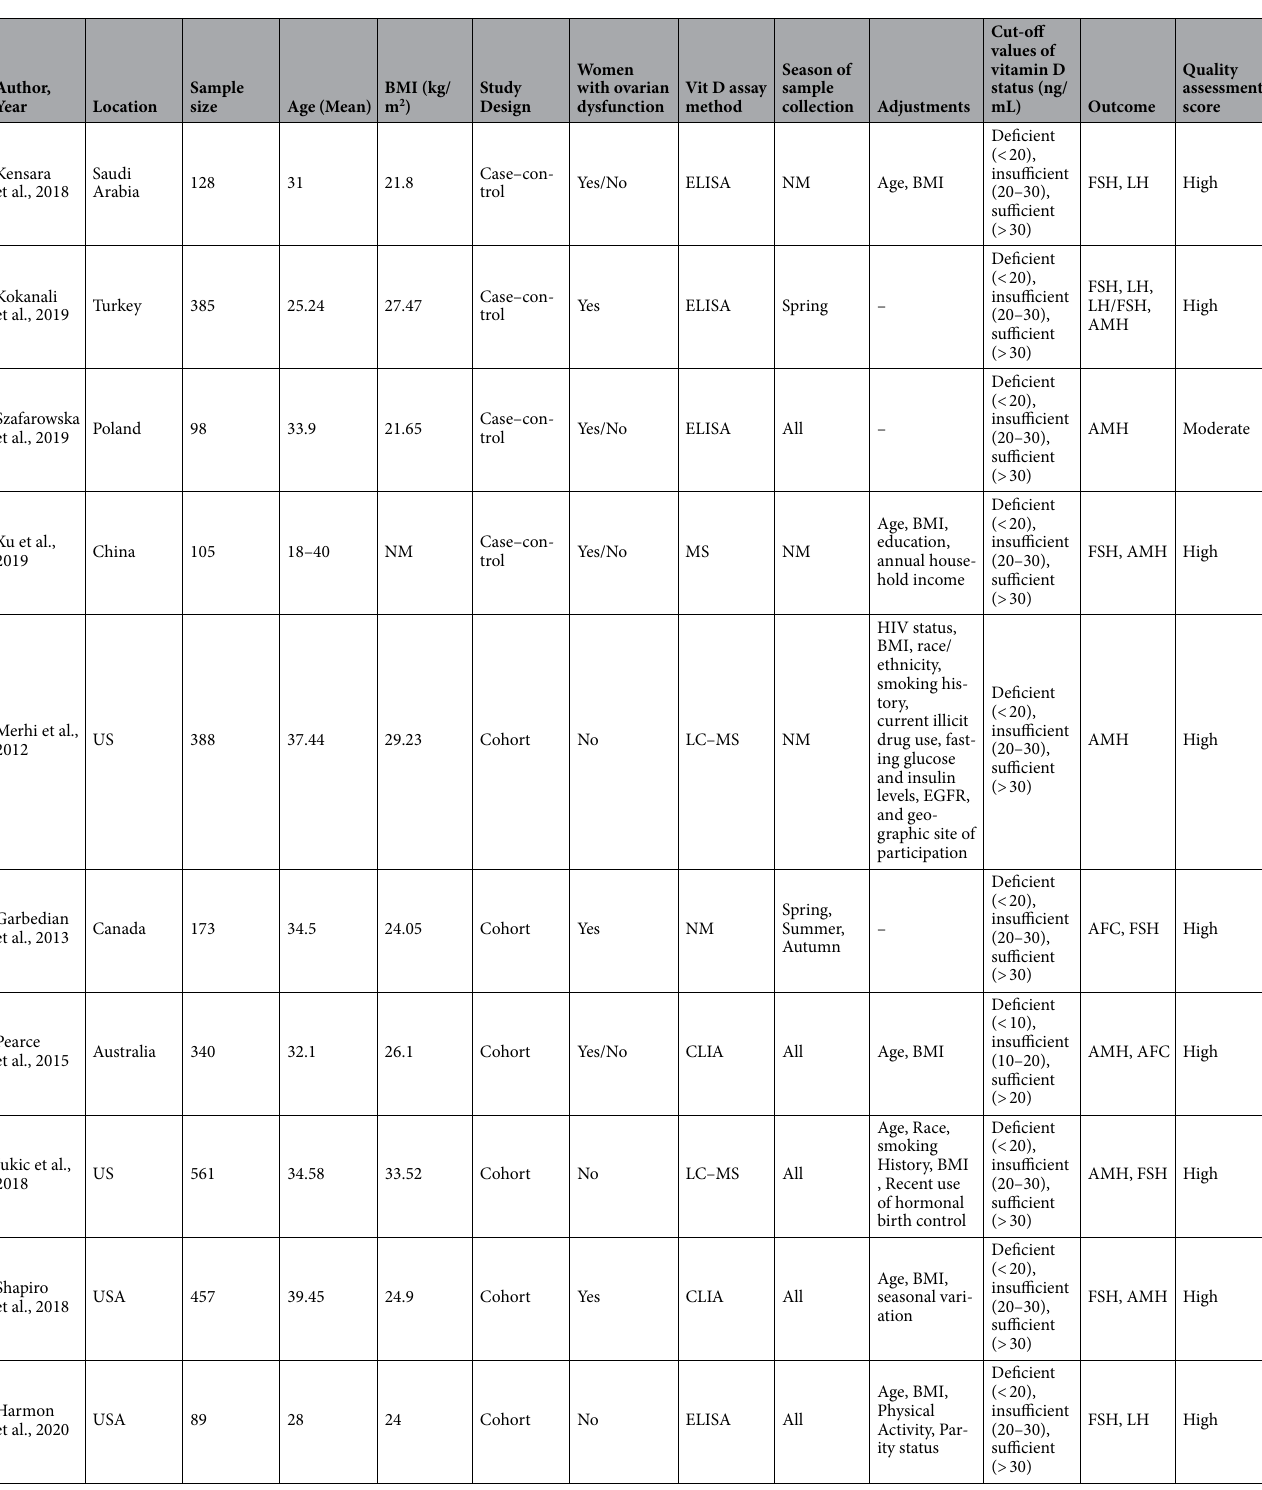
Table 1. Characteristics of included studies. HPLC high-performance liquid chromatography, CLIA chemiluminescent immunoassay, RIA radio immunoassay, ELISA enzyme-linked immunosorbent assay,